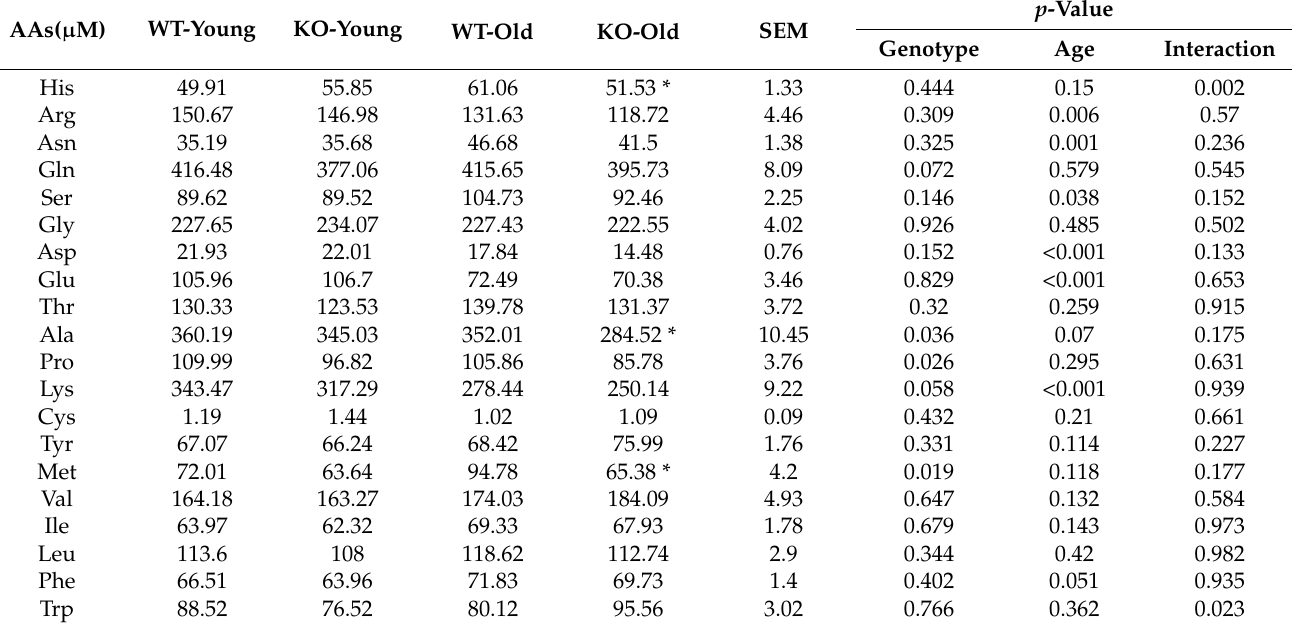
Table 2. Effects of GPRC6A deletion on serum free amino acids in mice at different growth